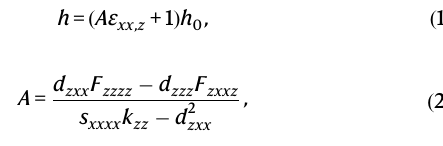
slope of the fi tted line of Fig. 3a (the top surface of BFO membrane used here is terminated on a Bi-O layer while bottom surface is ter-